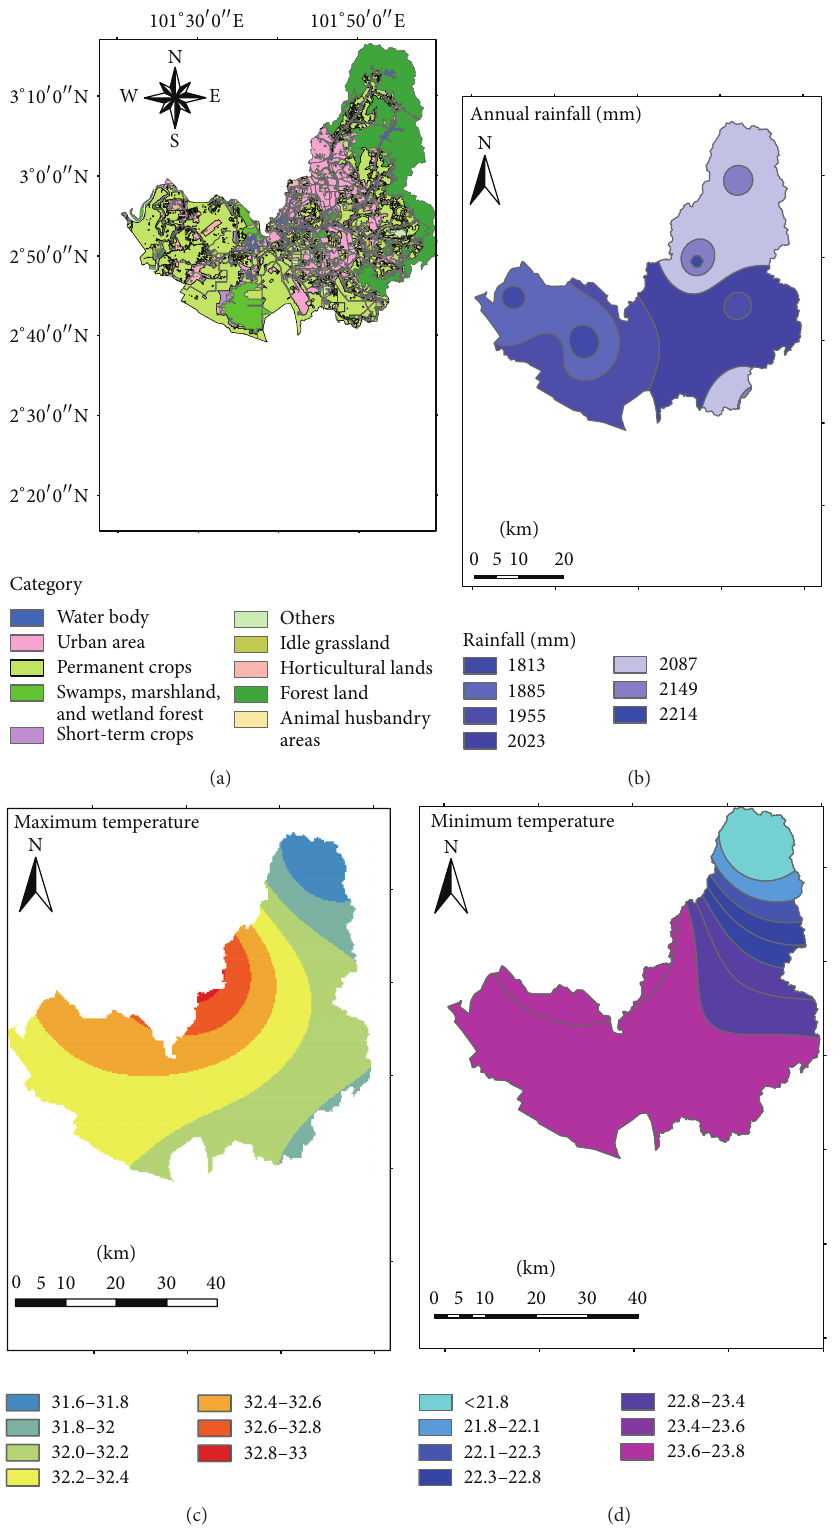
Figure 3: Spatial characteristics of the Langat River Basin include (a) land use map, (b) annual precipitation, (c) minimum temperature, and (d) maximum